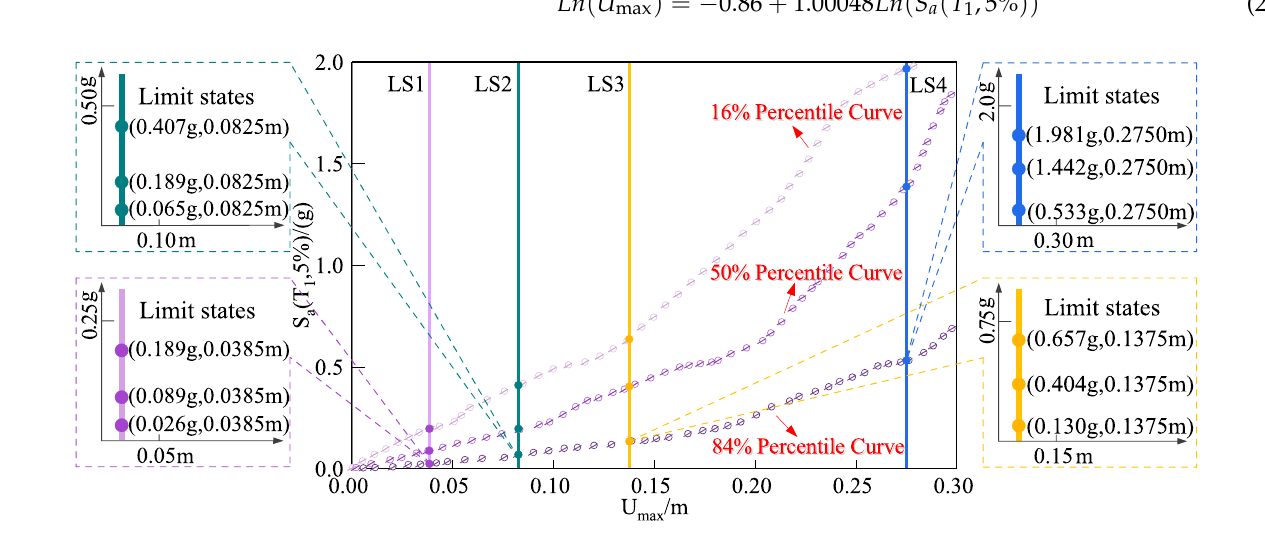
Figure 9. Percentile curves (IDA). Table 7. Corresponding capacity values of each limit state of structure.